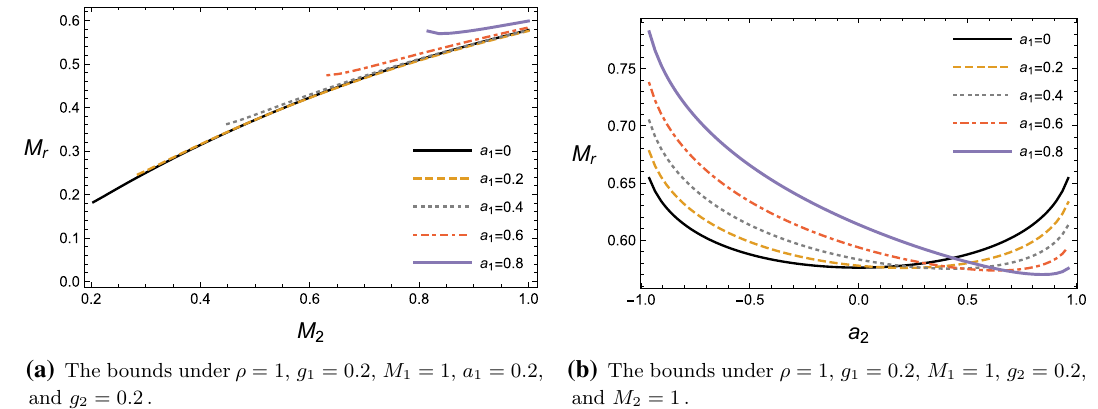
(b) The bounds under ρ = 1, g 1 = 0 . 2, M 1 = 1, g 2 = 0 . 2, and M 2 = 1.